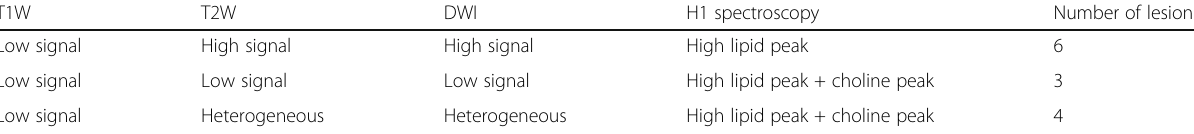
Table 1 Summary of signal characteristics of individual lesions in different pulse sequences in our patients